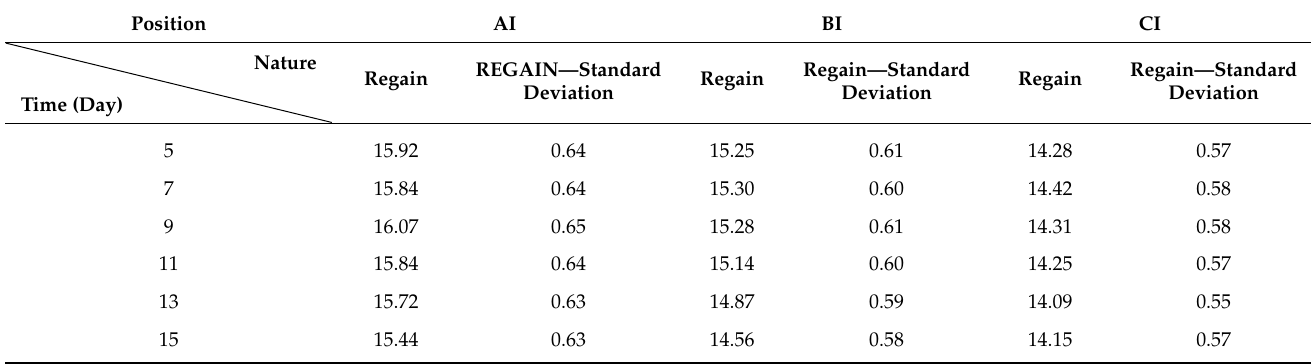
Table 1. Retting duration and fibre moisture regain of inner stem.